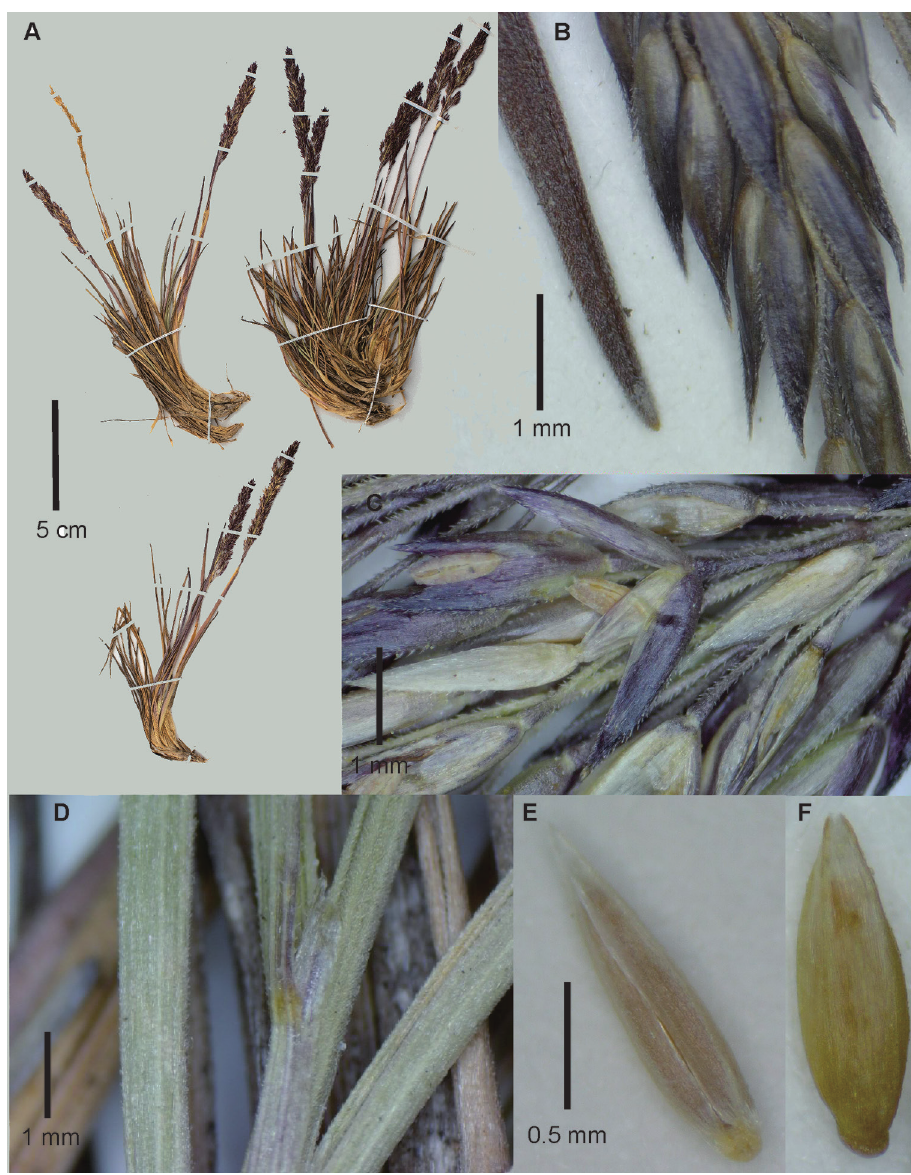
Figure 1. Agrostis boyacensis , examples of specimens from páramo or superpáramo of the Sierra Nevada del Cocuy A whole plant B close-up of inflorescence C spikelet at anthesis, lateral view D upper culm blades and ligular area E floret, ventral view F floret, dorsal view. Images A, C, D, F : Cleef 8504 (US01247250) courtesy of United States National Herbarium (US); B, E : Cleef 5665 (US2785695). Scale bar of E also for F .